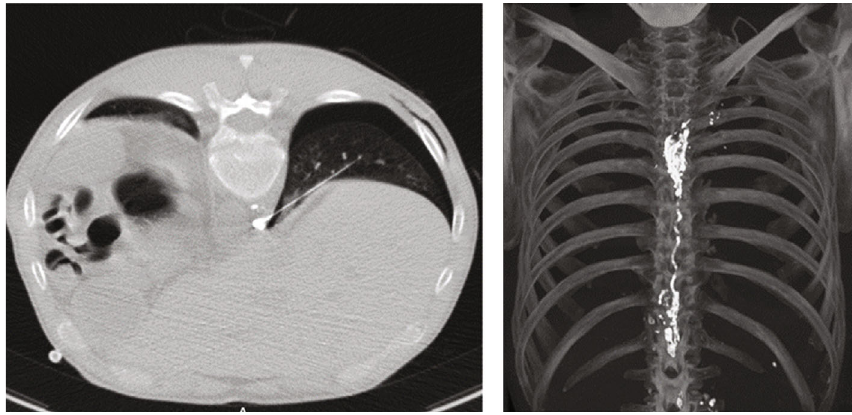
Figure 3: CT con fi rmation of the fi stula site embolization and